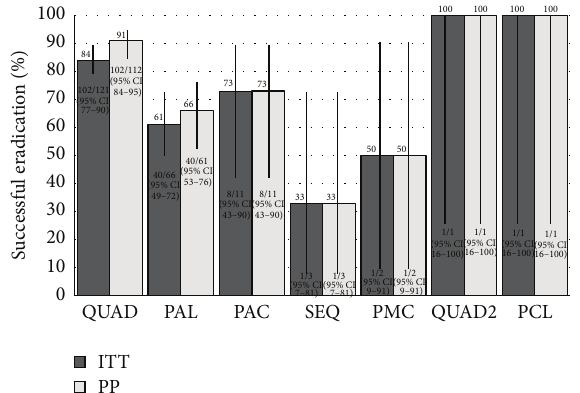
Figure 5: Per protocol (PP) and intention to treat (ITT) eradication of the different regimens as defined in Table 1. 𝑝 < 0.001 (ITT or PP) for bismuth quadruple versus other combined proton pump inhibitor(PPI)tripletherapies(PAL,PAC,andPMC,riskdifference: 25% (PP, 95% CI: 13–37) and 22% (ITT, 95% CI: 10–35)).